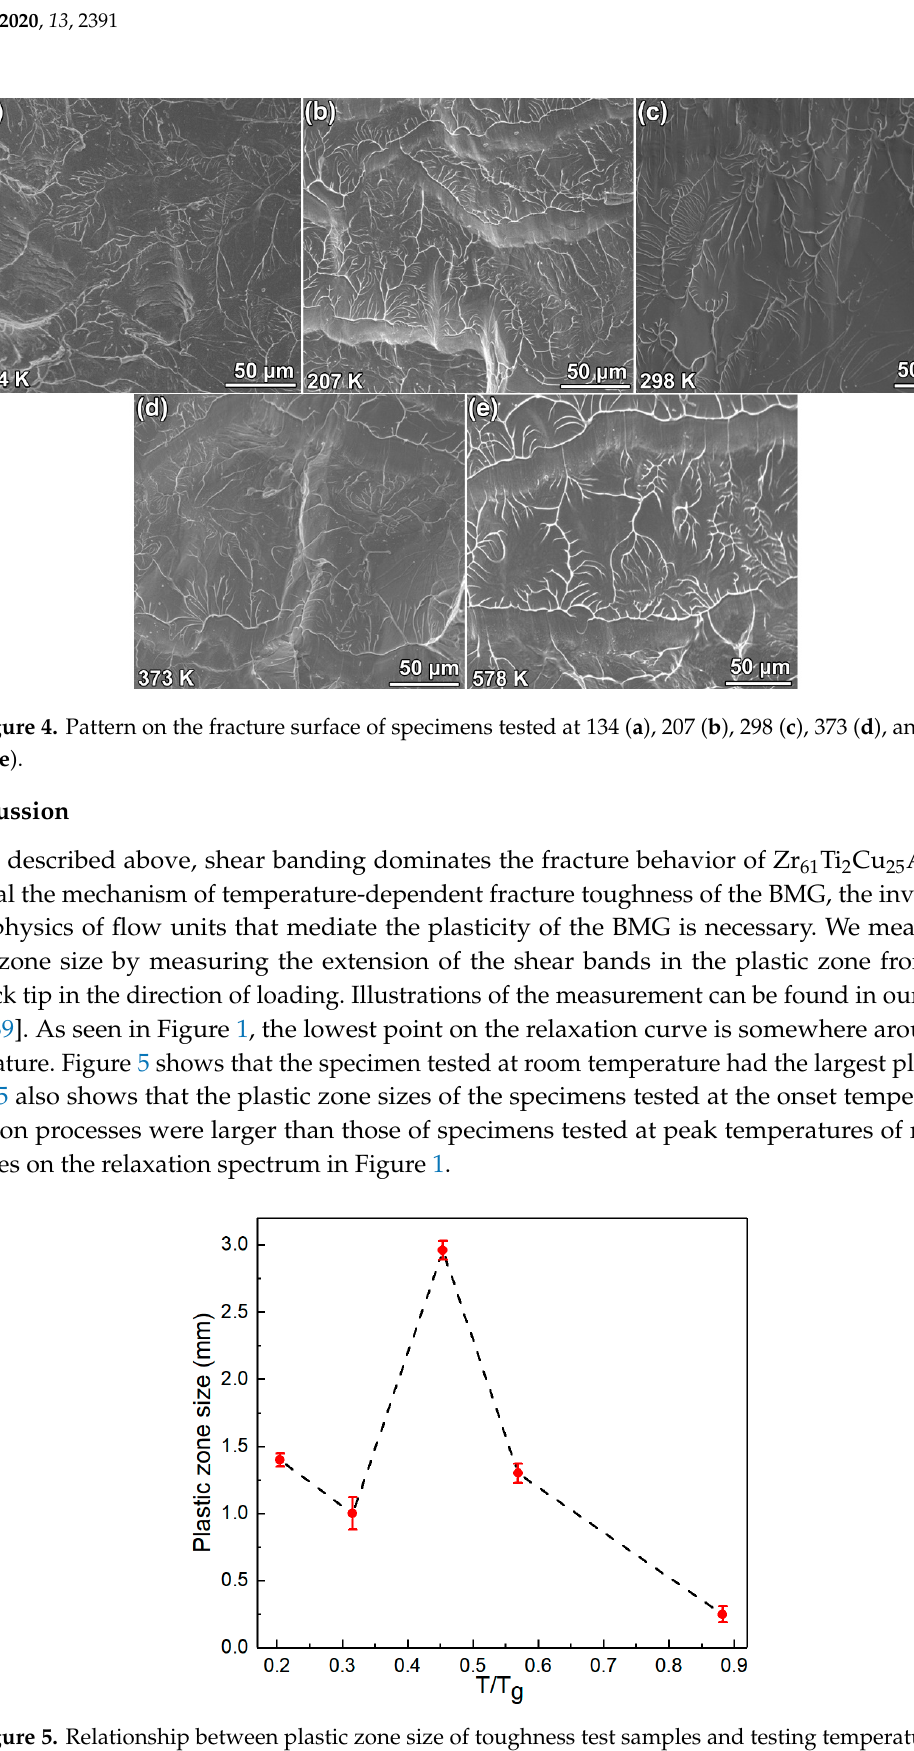
Figure 5. Relationship between plastic zone size of toughness test samples and testing temperature of the Zr 61 Ti 2 Cu 25 Al 12 BMG.